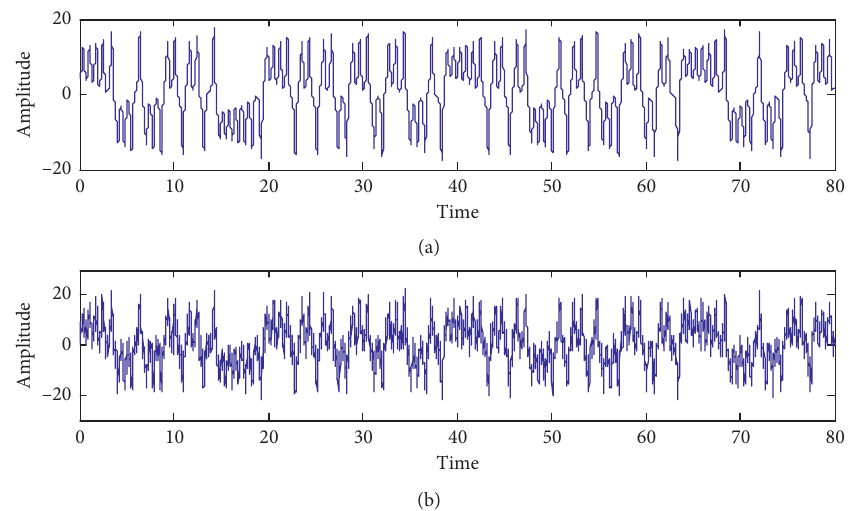
Figure 2: Time domain waveform of (a) noise-free signal and (b) noisy signals.